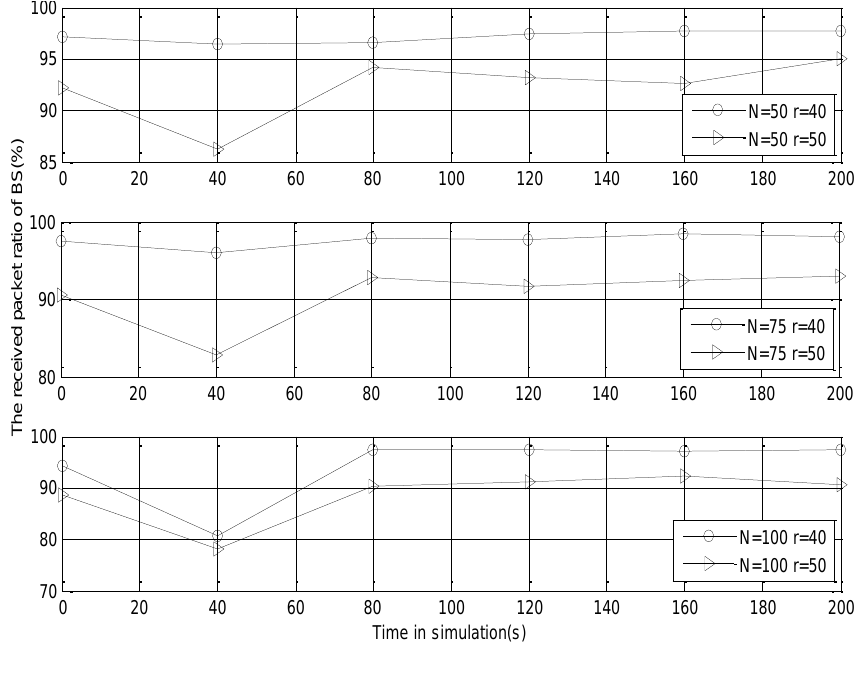
Figure 14. Different communication radius on the impact for